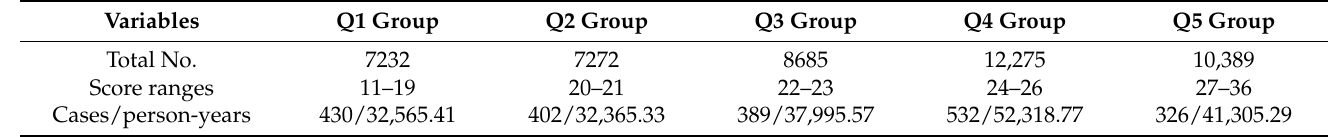
Table 2. Follow-up information of participants according to DASH dietary